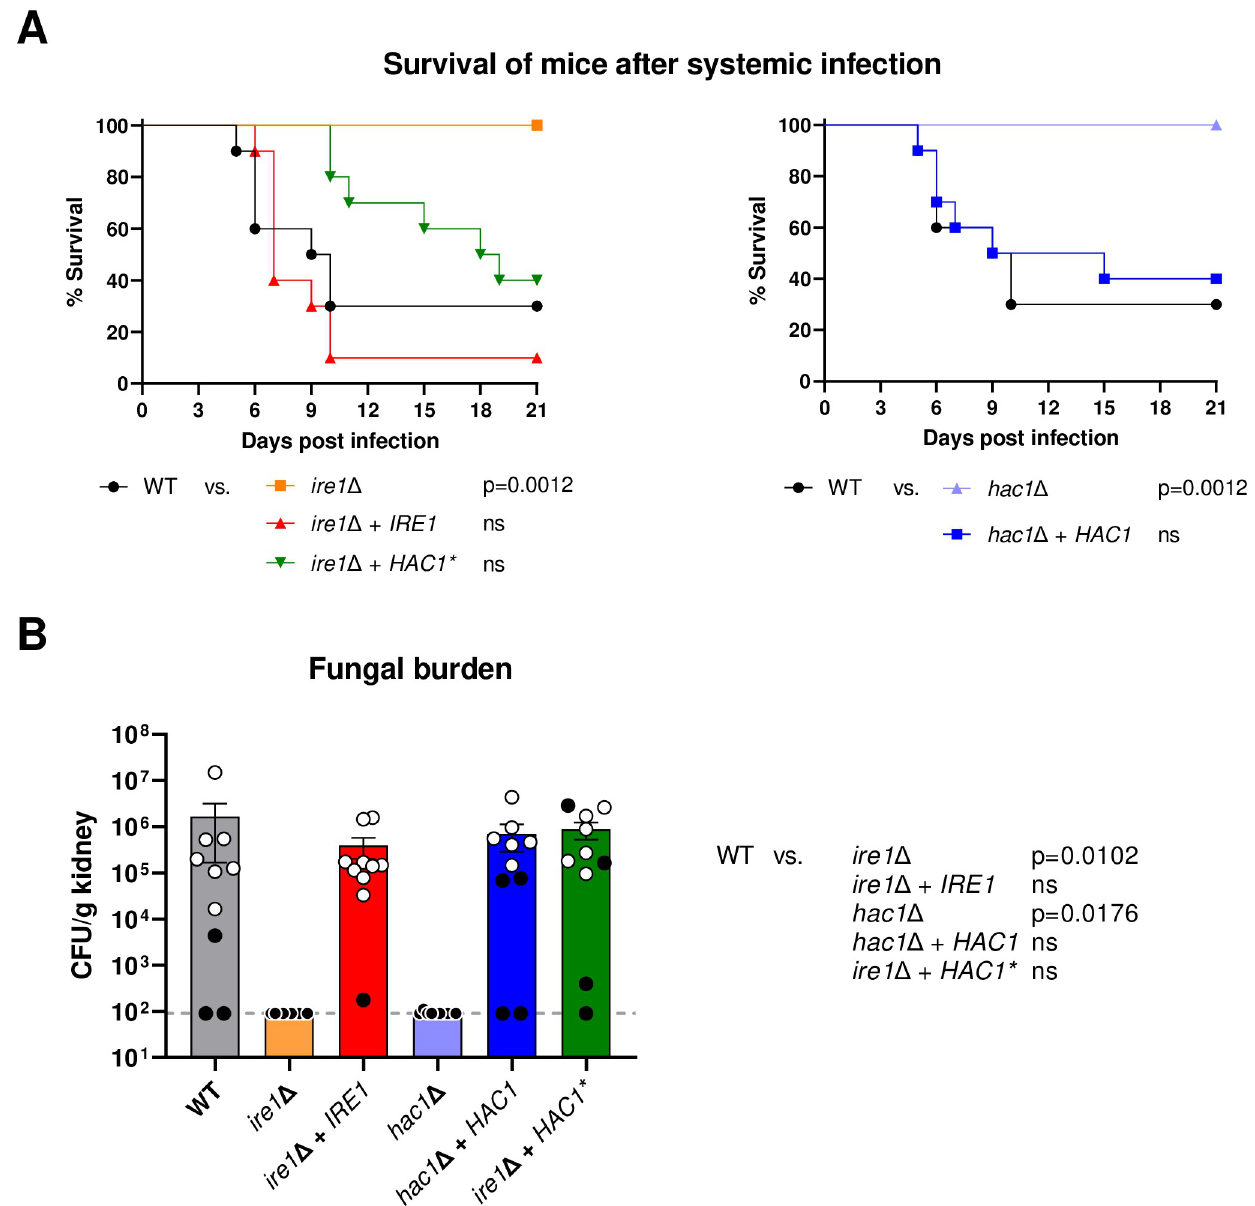
Fig 11. A pre-spliced HAC1 restores virulence in ire1 Δ mutants. (A) Kaplan-Meyer curves of mouse survival after infection with the wild-type strain SC5314, ire1 Δ mutants and complemented strains ( ire1 Δ + IRE1 ), hac1 Δ mutants and complemented strains ( hac1 Δ + HAC1 ), and ire1 Δ mutants containing an intron-less copy of HAC1 ( ire1 Δ + HAC1 � ). Pooled data from two independent experiments in which the wild type and the complete A or B series of mutants were tested in parallel (five mice per strain and experiment) are shown. Data are presented in two separate graphs for ease of comparison, with the data for the wild type included in both graphs. Pairwise comparison was performed using the Log-rank test; ns, not significantly different from the wild type. (B) Fungal burden in the kidneys of mice shown in (A), determined by plating of organ homogenates and calculation of CFU/g tissue. The horizontal line indicates the detection limit (90 CFU/g); for statistical analysis, samples from which no colonies were obtained were set to the detection limit. White circles represent data from animals reaching humane endpoints, black circles indicate mice sacrificed 21 days after infection. Bars represent mean and SEM. Data were analyzed by 1-way ANOVA followed by Kruskal-Wallis and Dunn’s multiple comparisons test to compare each strain to the wild type.